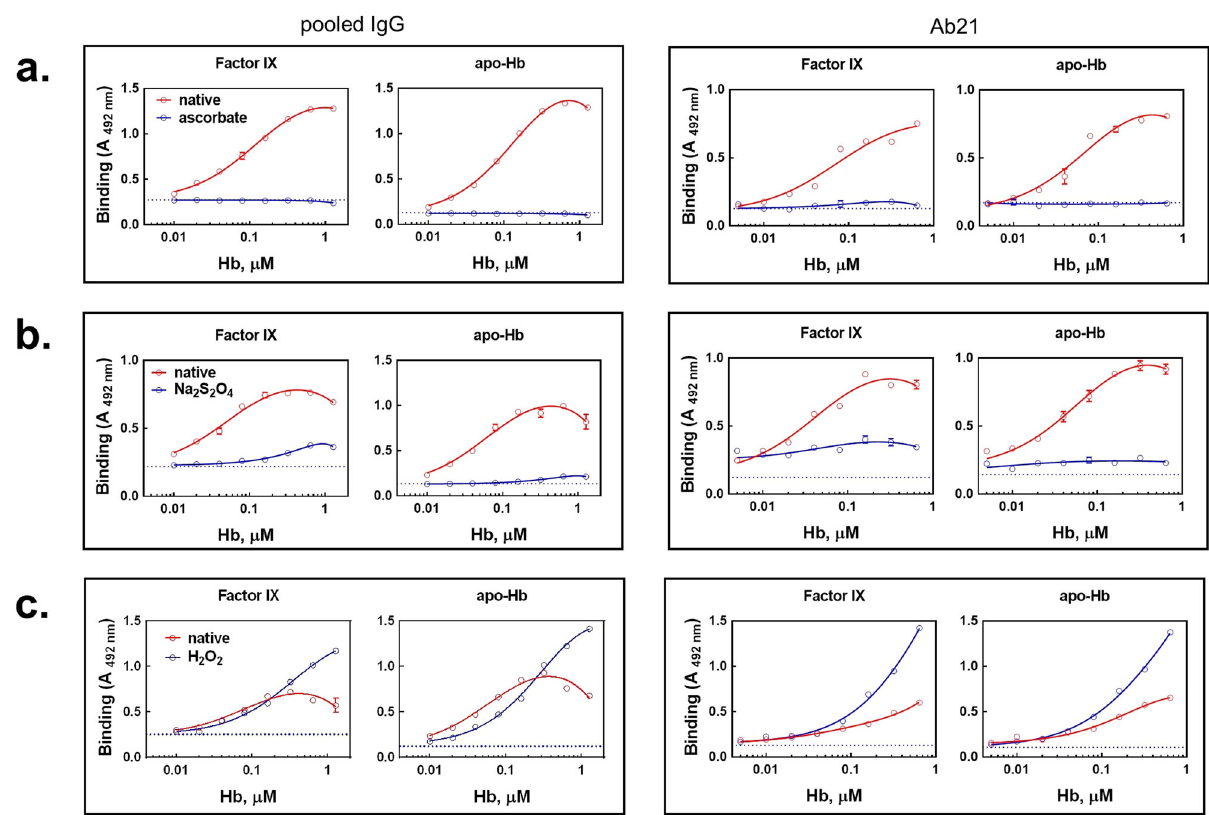
Fig. 2 Pro-oxidative potential of heme plays an essential role in modi fi cation of antigen-binding speci fi city of antibodies by metHb. Pooled human IgG and a monoclonal IgG1, Ab21 at 10 and 2 μ M, respectively were exposed to increasing concentrations of metHb in the absence (red lines and symbols) or in the presence of: a 100 μ M ascorbic acid; b 0.5- and 2-mM sodium dithionite, for pooled IgG and Ab21, respectively; and c 1 mM hydrogen peroxide (blue lines and symbols). After incubation for 30 min the samples were diluted 10× and incubated with immobilized factor IX and apo-Hb. Each data point represents mean absorbance ±SD from n = 3 repetitions of each sample. The dashed lines represent the reactivity of native IgG. Representative results from two independent experiments (pooled IgG) or one experiment (Ab21) are